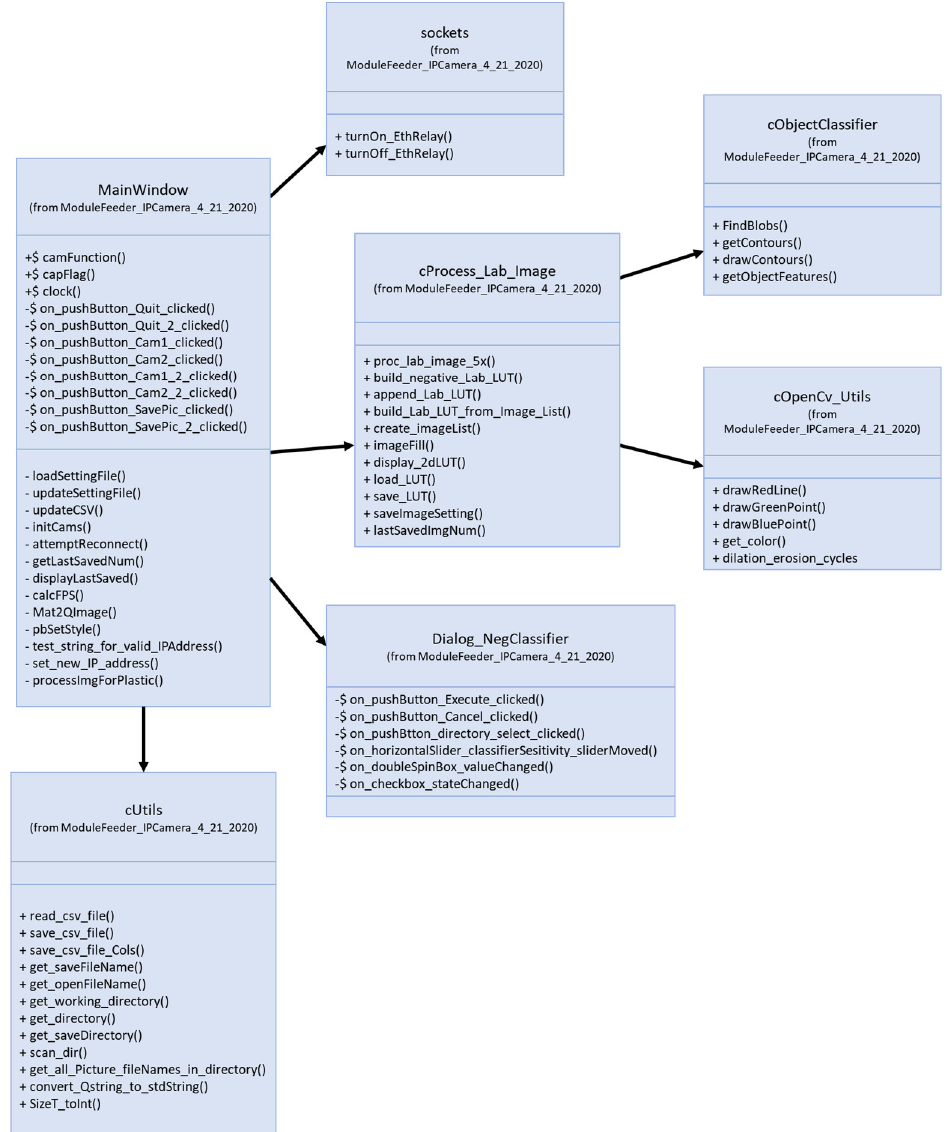
Figure 21. The C++ class definitions used in the module inspection system software. In the figure’s class specifications, the leading ‘+’ signifies public functions, while the leading ‘-’ signifies private functions and the leading ‘$’ signifies event response function (SLOT) that are called and used by the windowing event loop structures. The SLOT functions provide the equivalent of an interrupt service routine that frees up active process from having to continuously poll various resources for data event occurrences. The class structure is flat with no inheritance by any of the classes; the arrows between classes only indicate which class is calling other classes by means of publicly visible functions.